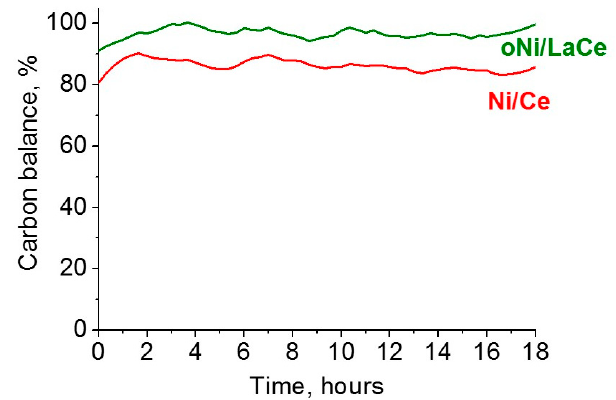
Figure 7. Carbon balance vs time of reaction at 550 °C for Ni/Ce and oNi/LaCe samples.